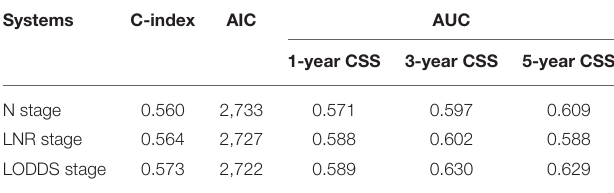
TABLE 3 | Prognostic efficiency of different lymph node staging